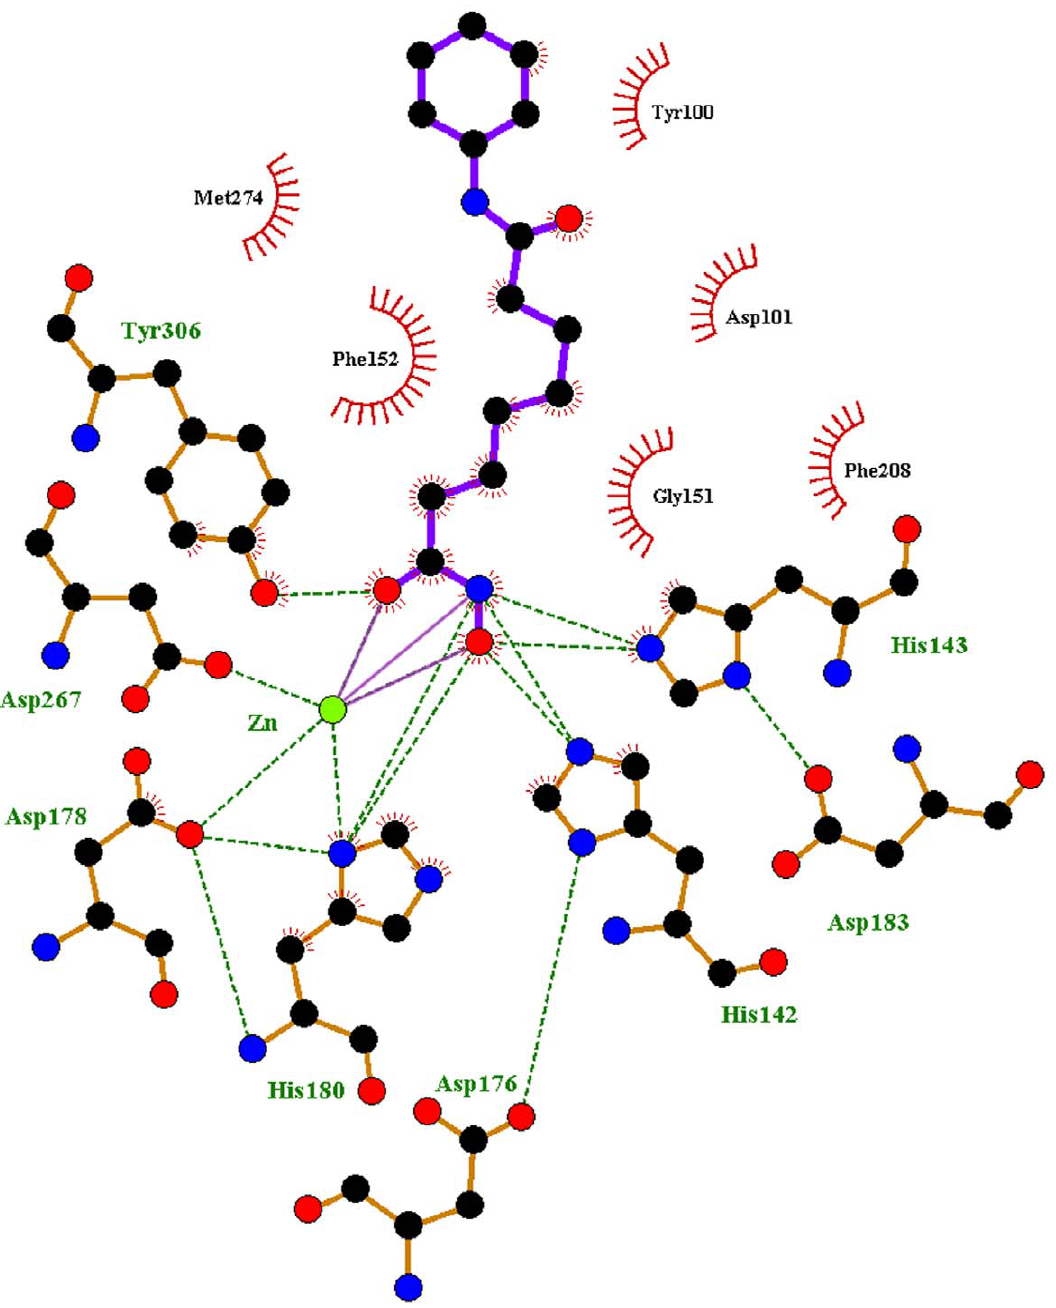
Figure 1. A diagrammatic representation of ligand binding at the tunnel-like active site of HDAC8. The binding of SAHA, the first FDA approved drug for HDAC inhibition, along with arrangement of charge relay system and tunnel-forming residues and their interactions with the ligand are denoted.